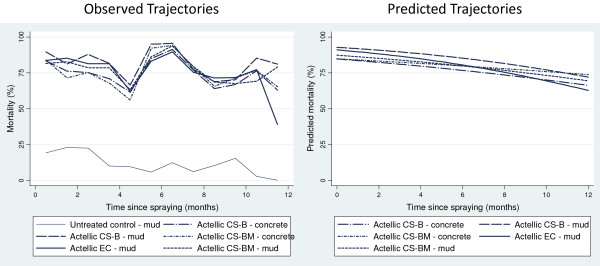
Mortality of wild Anopheles arabiensis freely entering experimental huts over 12 months after spraying. Data on wild mosquitoes recorded on a daily basis were variable. Graphs of observed mortality over time plot data pooled for each month since spraying.